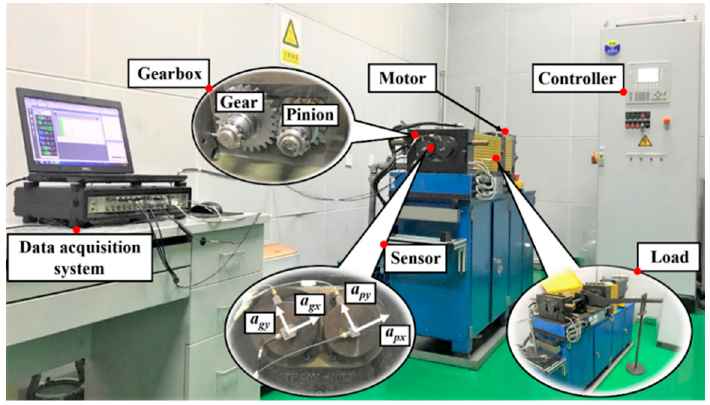
Figure 6. The gear test-rig.